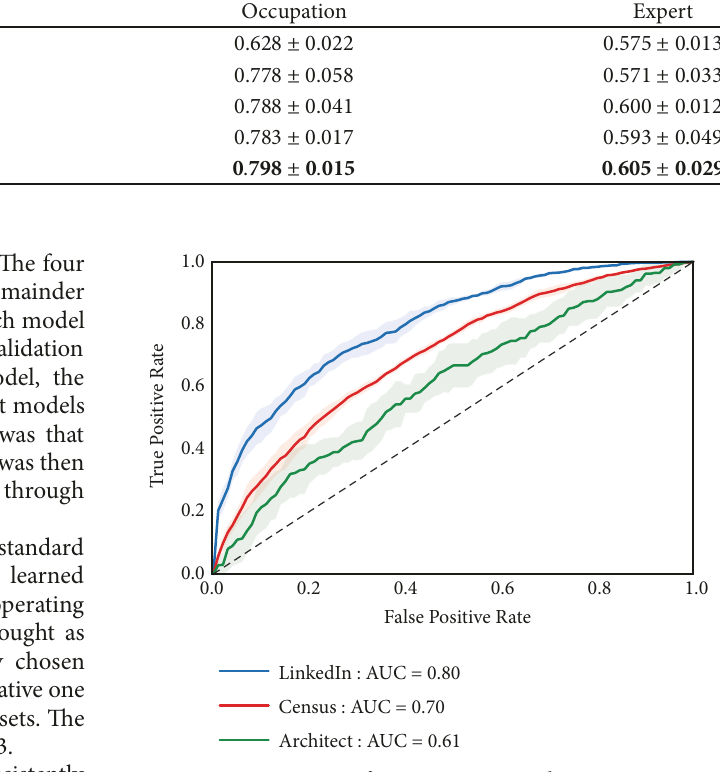
Figure 9: ROC curves for 2-way SES prediction using tuned XGBoost in each of the 3 SES datasets. AUC values are reported in the legend. The dashed line corresponds to the line of no discrimination. Solid lines assign average values over all folds while shaded regions represent standard